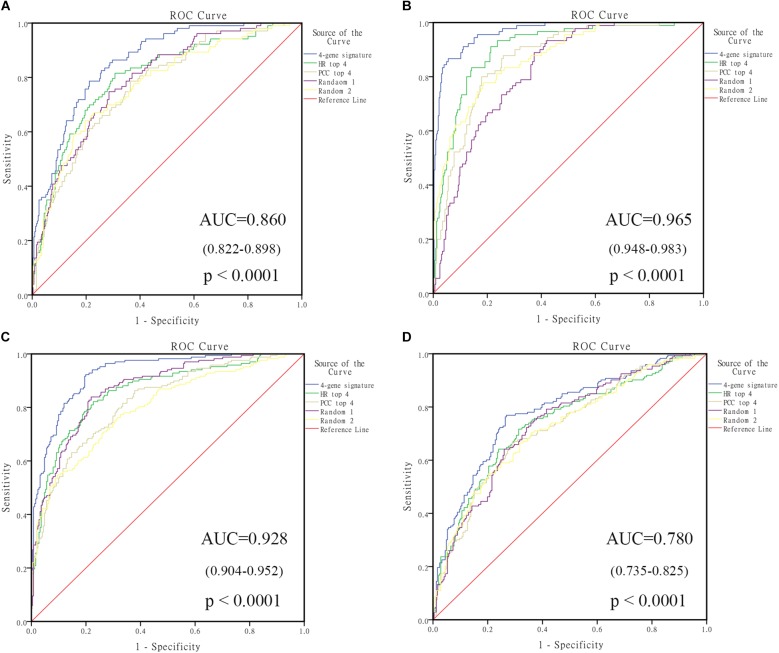
The receiving operating characteristic curve (ROC) of GSE49710. (A) ROC of vital status; (B) ROC of MYCN amplified; (C) ROC of high risk; (D) ROC of progression. HR, hazard ratio; PCC, Pearson correlation coefficient.